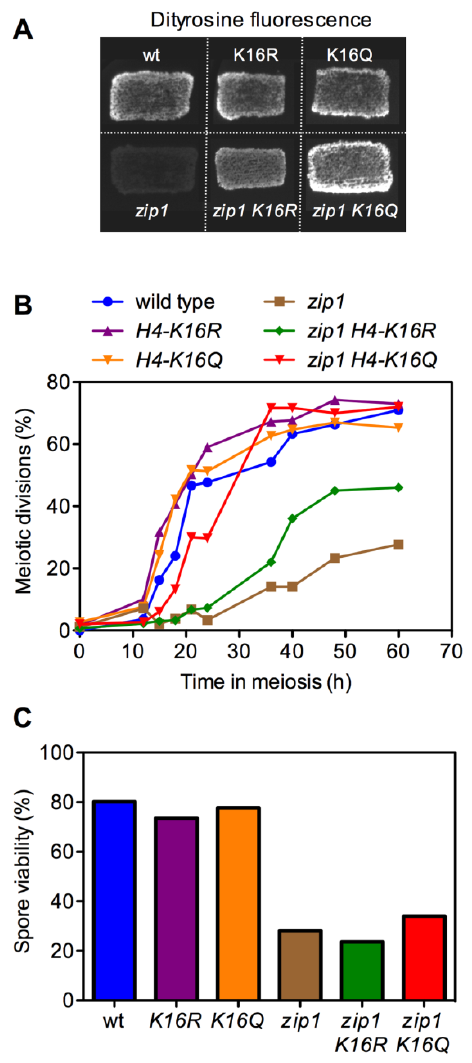
FIGURE 2: The meiotic recombination checkpoint is impaired in H4-K16R and H4-K16Q mutants. (A) Dityrosine fluorescence, as an indicator of sporulation, was examined after 3 days of sporula- tion on plates. (B) Time course of meiotic nuclear divisions; the percentage of cells containing two or more nuclei is represented. (C) Spore viability, as assessed by asci dissection, is presented. At least 144 spores were scored for each strain. Strains used in (A) are DP421 (wild type), DP994 ( H4-K16R ), DP1000 ( H4-K16Q ), DP422 ( zip1 ), DP995 ( zip1 H4-K16R ) and DP1001 ( zip1 H4-K16Q ) . Strains used in (B) and (C) are DP634 (wild type), DP635 ( H4- K16R) , DP636 ( H4-K16Q) , DP639 ( zip1) , DP640 ( zip1 H4-K16R) and DP641 ( zip1